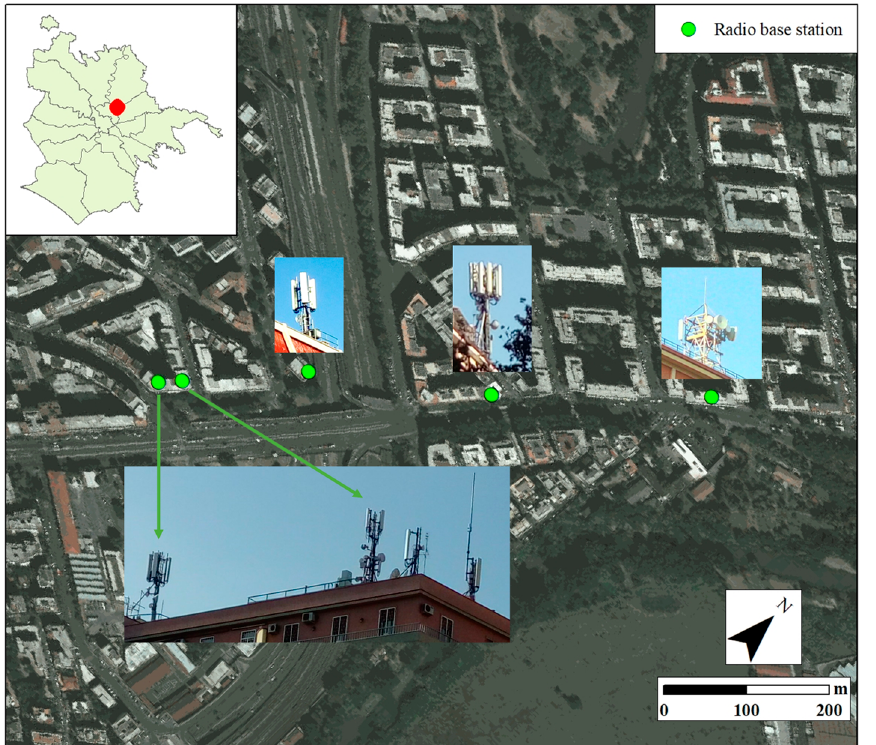
Figure 1. Geolocalization on an aero-satellite image of an alignment of (probable) radio base stations (RBSs) diffused on some buildings in a sector of north-east Rome and the photos obtained during the field surveys. Source: authors’ elaboration.